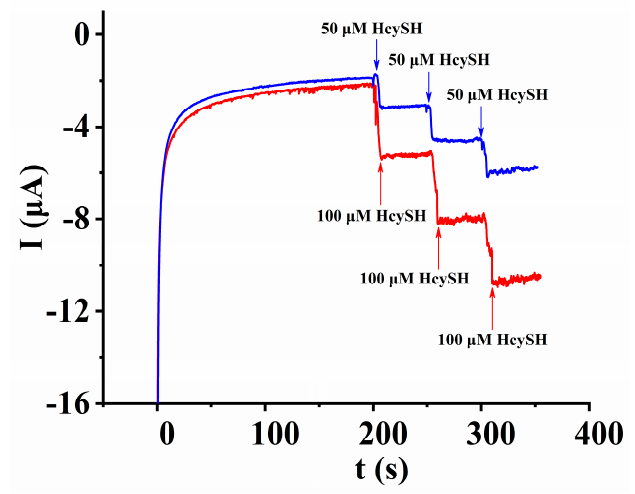
Figure 11. Amperometric response of 50 µ M and 100 µ M HcySH on AuNPs/AB–DHP/GCE in 0.15 M PBS containing normal human serum sample. The work potential is 0.6 V.